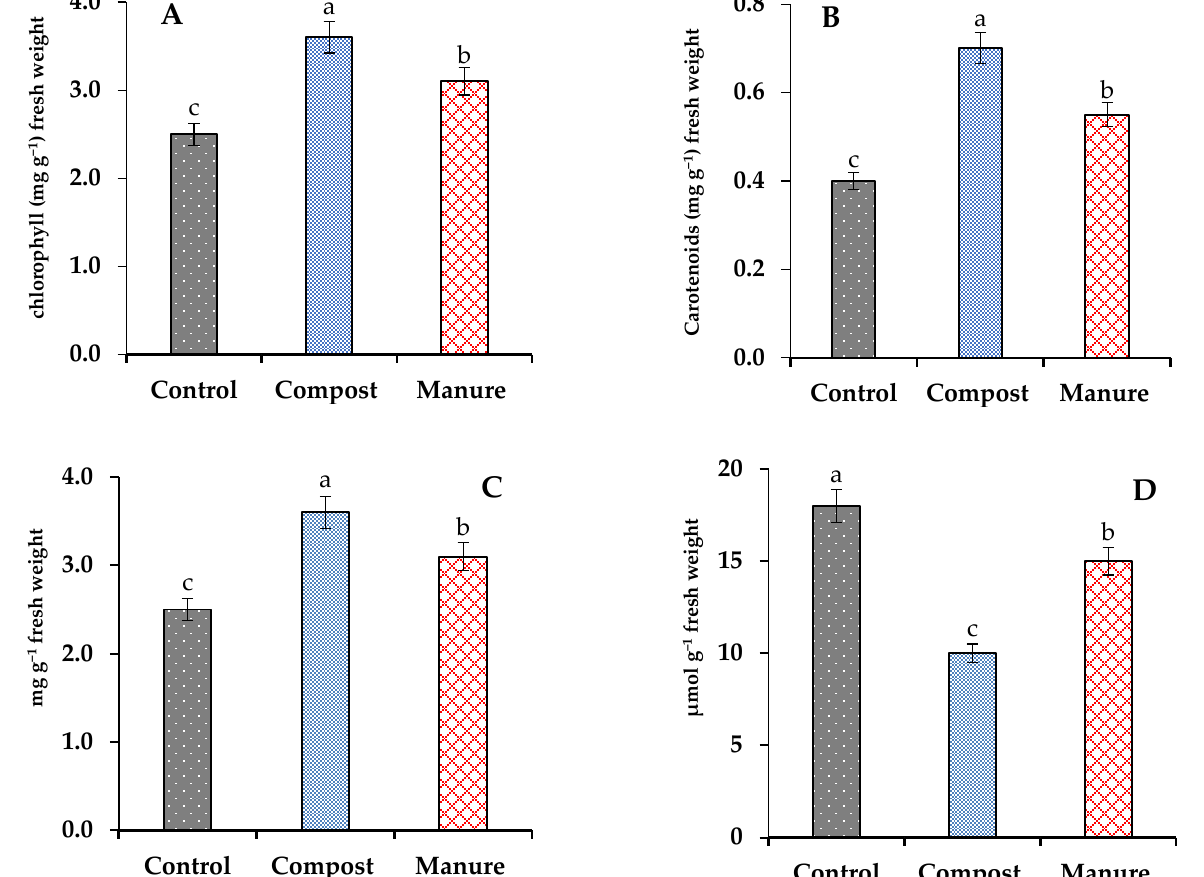
Figure 1. Effect of compost and manure on photosynthesis pigments ( A ) Total Chlorophyll, ( B ) Carotenoids), ( C ) Proline content, and ( D ) Malondialdehyde (MDA). Means ( ± standard deviation, n = 4) denoted by different letters are significantly different at p < 0.05. All the data are based on fresh weight.